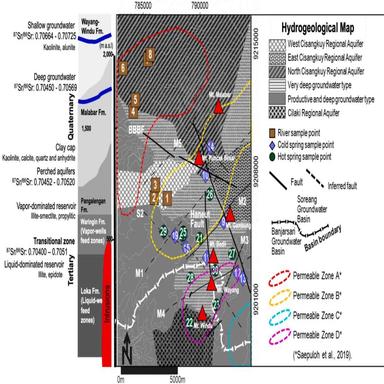
Hydrogeological map showing six types of aquifers of shallow and deep groundwater. Among the permeable zones defined by, zones B and D are considered the most permeable and act partly as pathways for ascent of deep fluids. The major fault system is composed of the Bandung Basin Boundary Fault (BBBF), N–S-trending Haneut Fault, and five NE–SW-trending Meratus faults labeled M1–M5, modified after The left column shows the depth range of the main hydrothermal alteration minerals toget